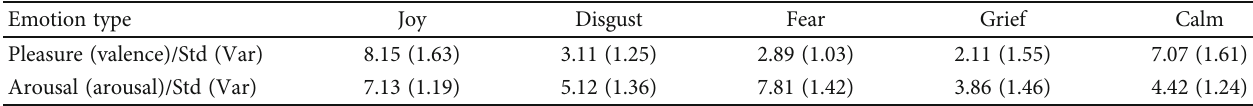
Table 1: Target emotion localization.